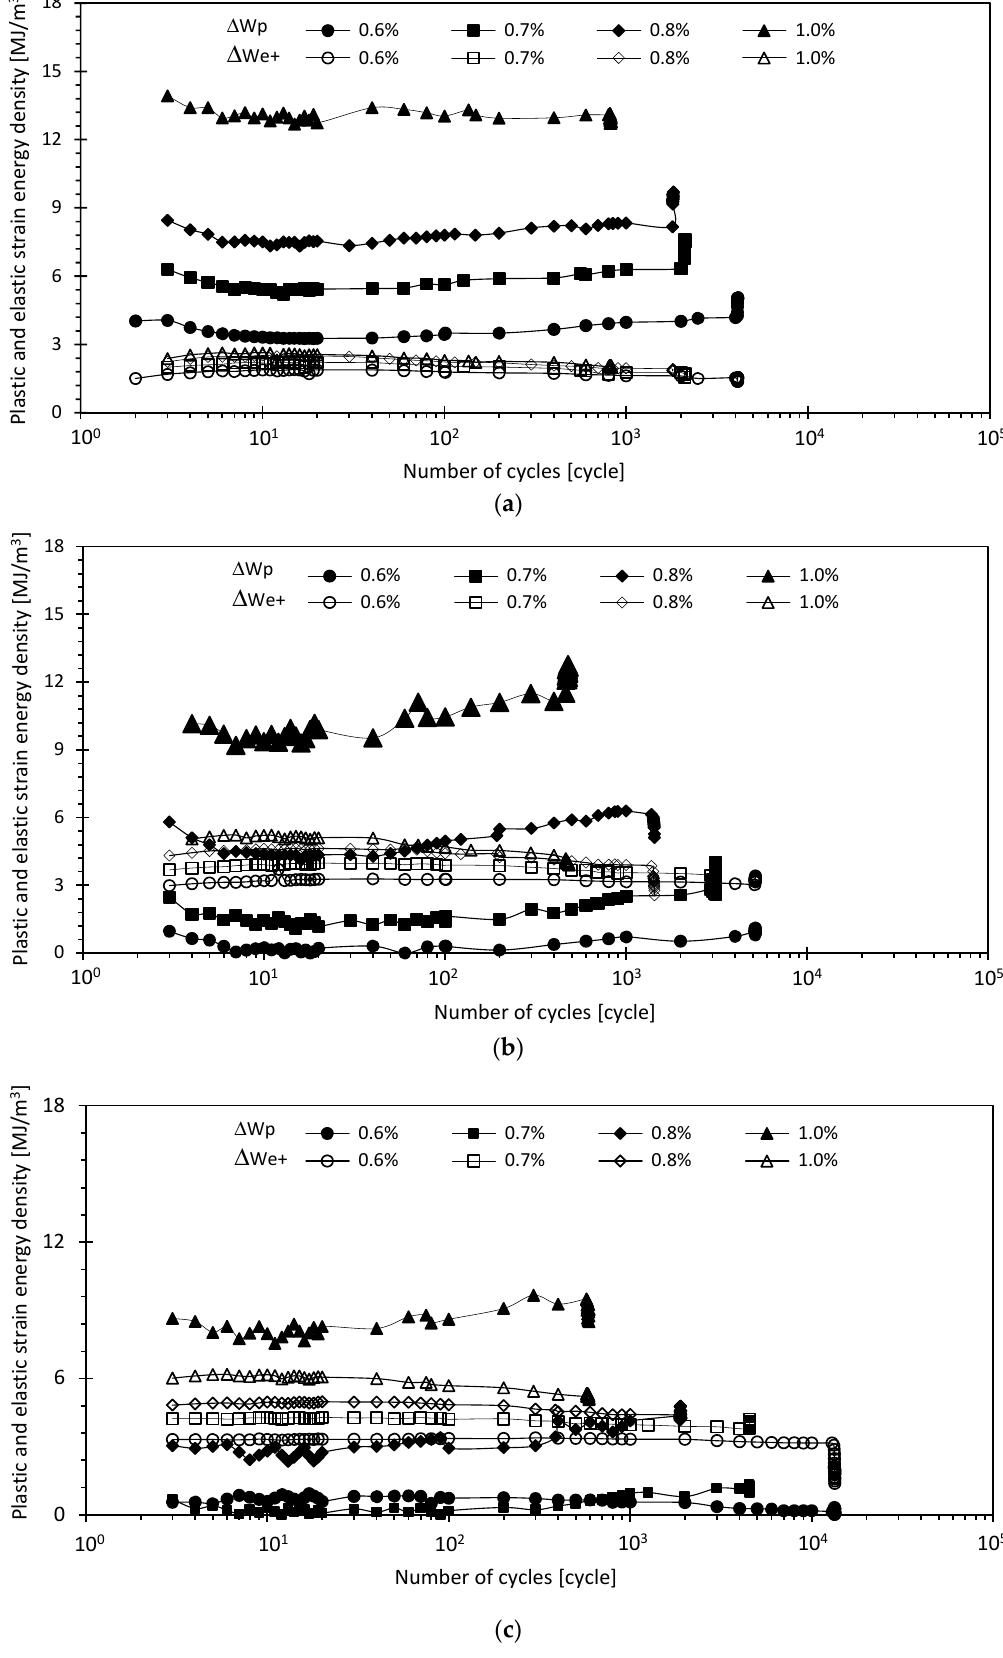
Figure 3. Plastic ( ∆ Wp) and elastic ( ∆ We ) strain energy densities per cycle as a function of strain amplitude for: ( a ) steel A; ( b ) steel B; and ( c ) steel C.